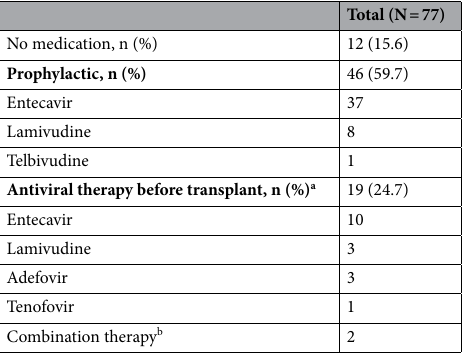
Table 2. Details of antiviral medications at the time of transplantation. a At least 3 months before transplant. b 1 Adefovir + telbivudine and 1 adefovir +